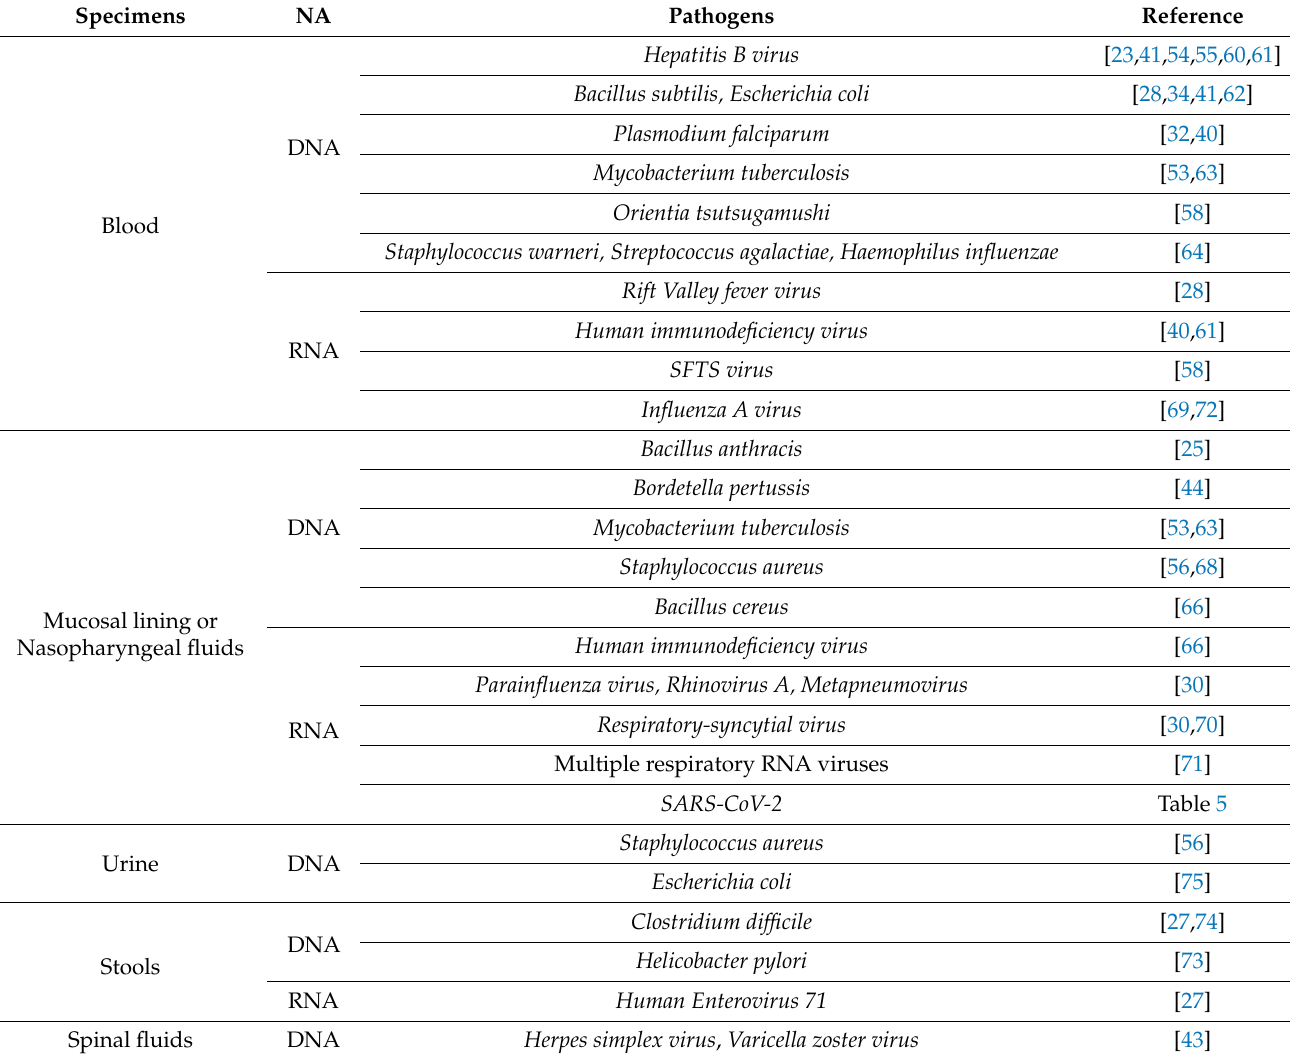
Table 4. List of pathogens detected with the described